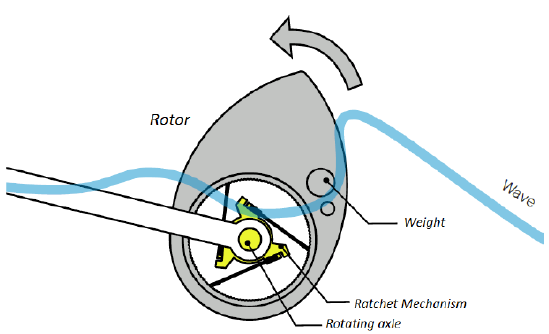
Figure 16. The ratchet mechanism in the WEPTOS converter [105]. A contribution by Jens-Peter Kofoed.